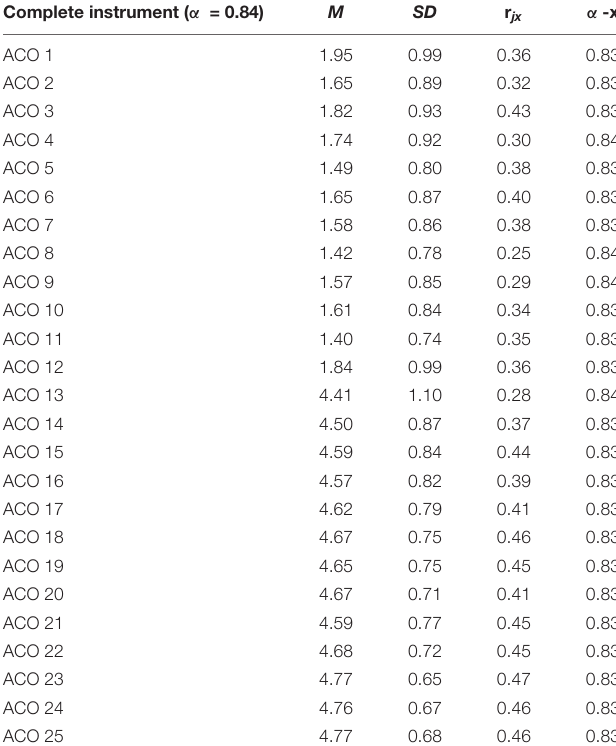
TABLE 1 | Analysis of the attitudes toward communication (ACO) for nursing students items: Mean (M), SD, item-total correlation (r jx ), and Cronbach’s alpha if it eliminates the element ( α